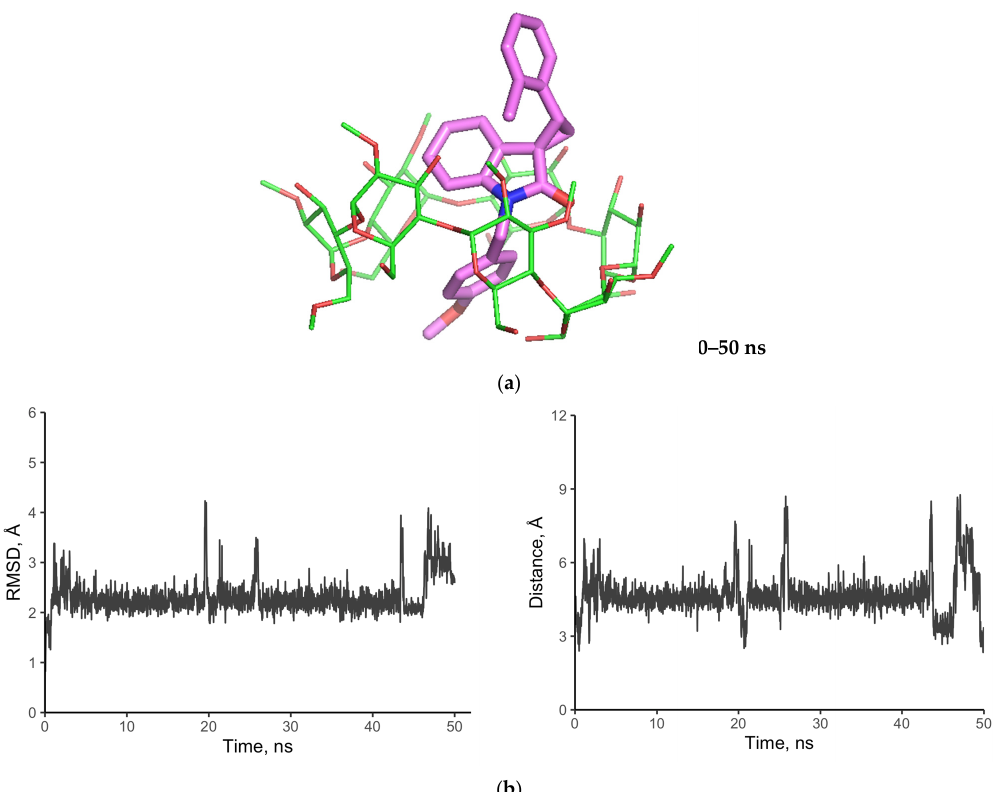
Figure 13. ( a ) Root-mean-square deviation (RMSD) and distance between the M β CD and 2b centers of geometry (Type III complex). ( b ) Type III complex structure transformation into Type II geometry.